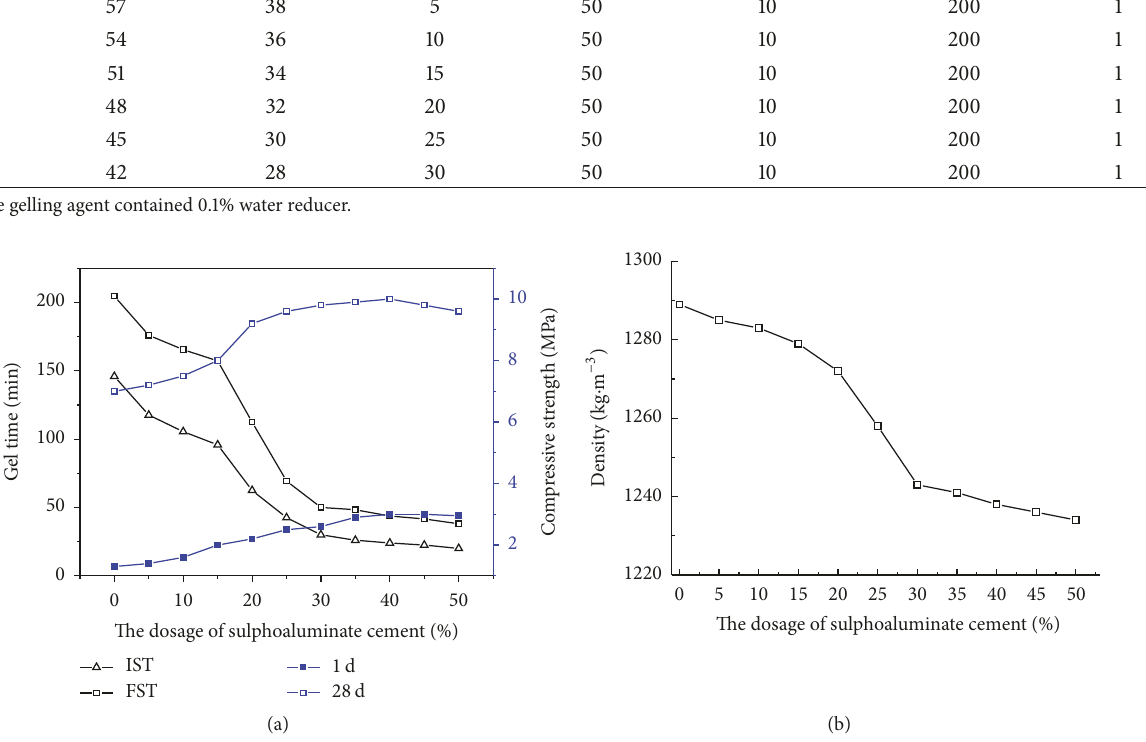
Figure 2: Effect of the dosage of sulphoaluminate cement on the filling material. Note . IST: initial setting time; FST: final setting